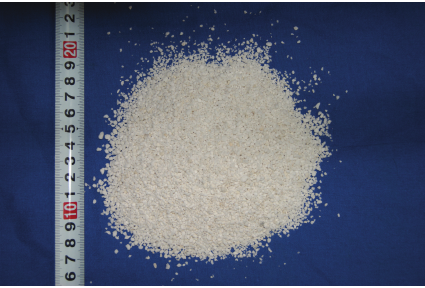
Figure 4: The appearance of